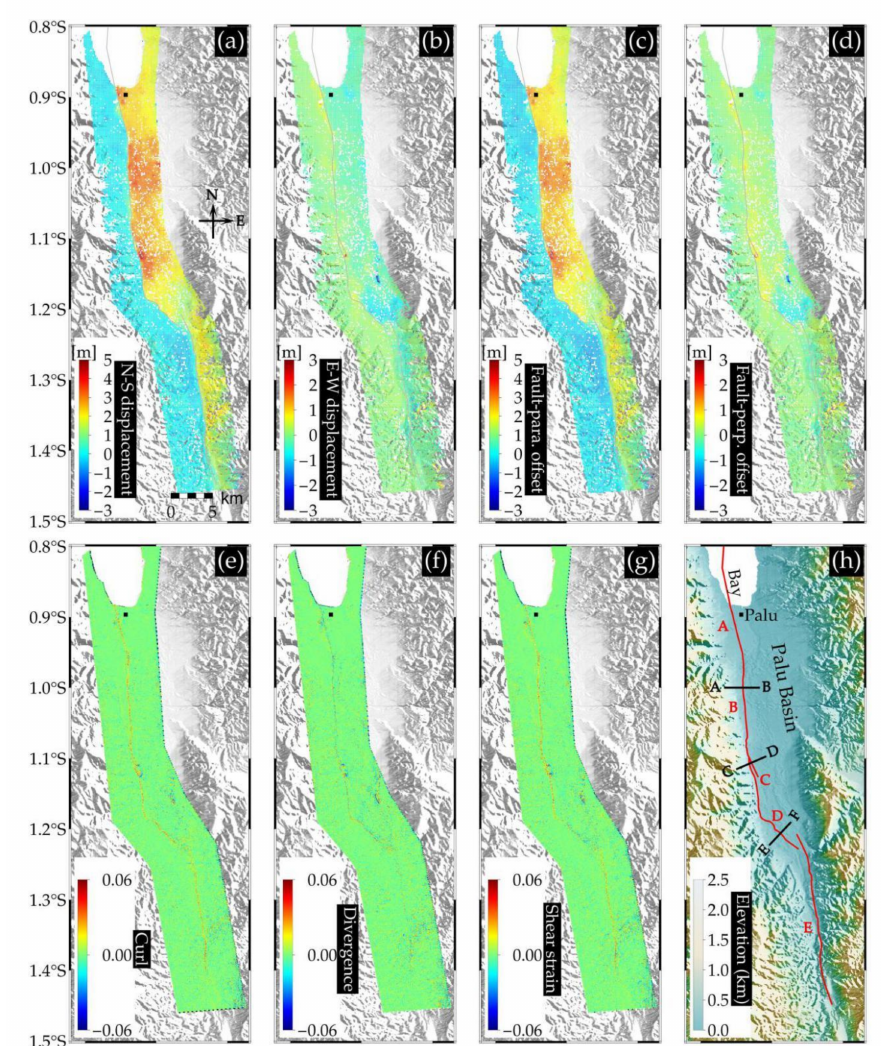
Figure 3. Detailed surface rupture within the Palu basin. ( a ) North-south (NS) component of the horizontal displacement; ( b ) east-west (EW) component of the horizontal displacement; ( c ) fault-parallel displacement field derived from NS and EW displacements; ( d ) fault-perpendicular displacement field derived from NS and EW displacements; ( e ) curl ( ω ), where positive ω at the fault corresponds to left-lateral strike-slip rupture; ( f ) divergence ( δ ) where negative δ at the fault indicates shortening and positive δ indicates extension; ( g ) shear strain ( γ ), where the major releasing bend is highly consistent with decreasing γ , and even disappears from the shear strain map; ( h ) surface rupture trace extracted from the curl, divergence, and shear strain maps. The black lines (AB, CD and EF) represent the cross-fault profiles in the Figures 5–7,